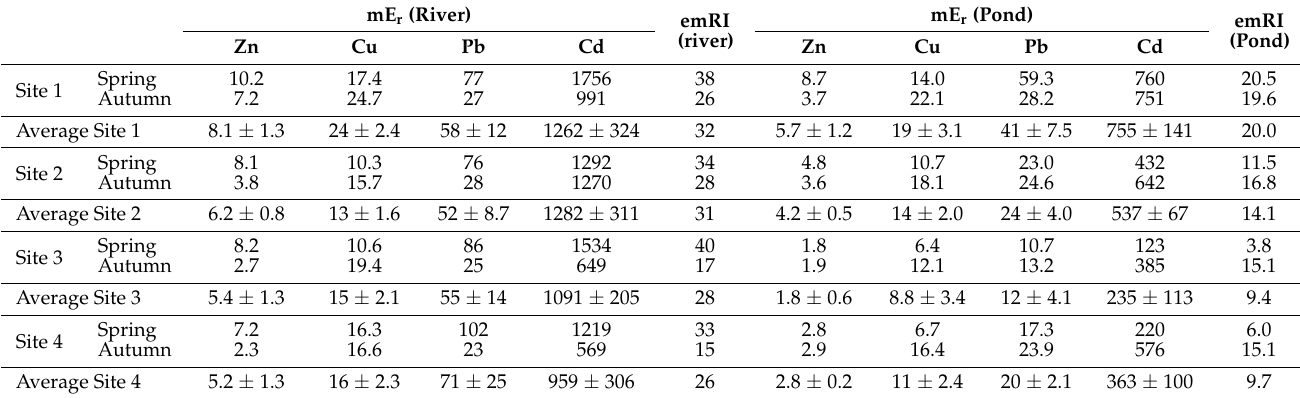
Table 4. Modified potential ecological risk factors (mEr) and expanded, modified potential ecological risk indexes (emRI) for metals mixtures in surface sediments of rivers and ponds at different